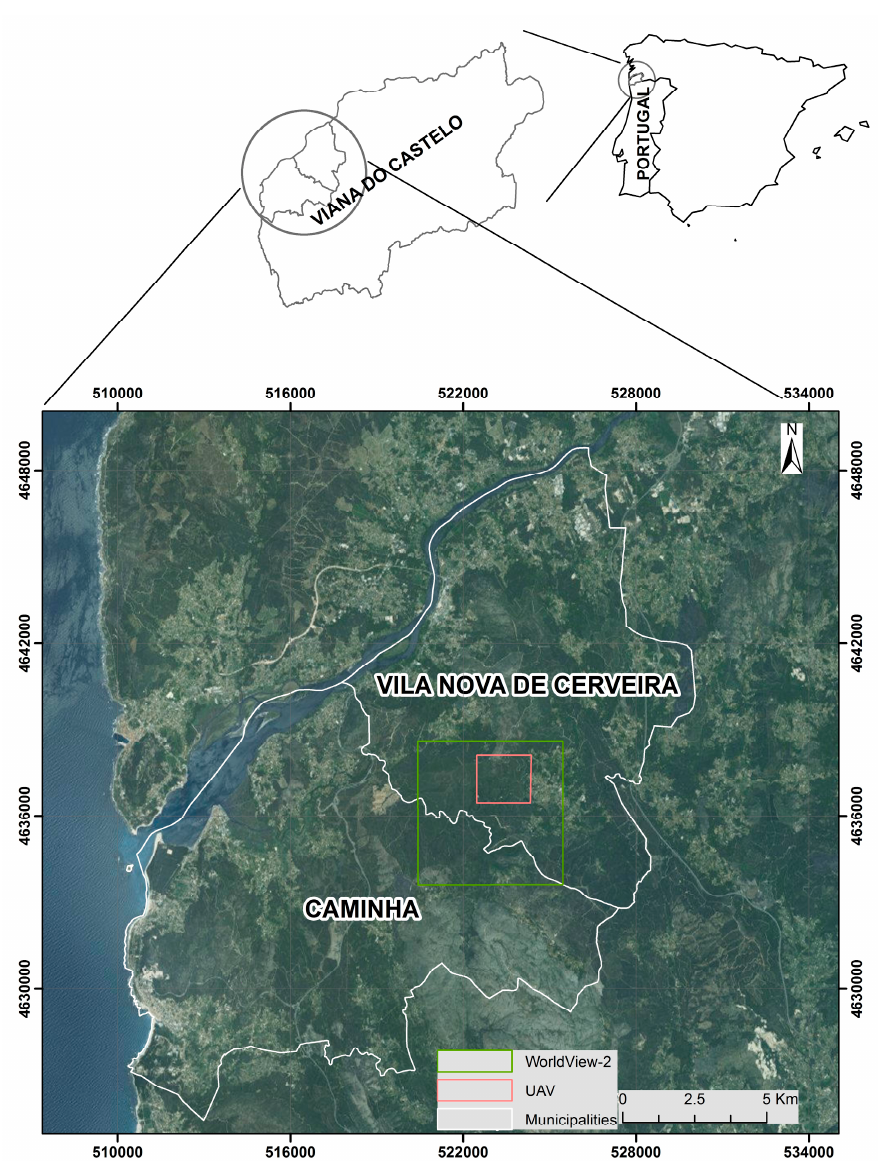
Figure 1. Study area located in Viana de Castelo (the North of Portugal), in the municipalities of Caminha and Vila Nova de Cerveira. Most of the land is covered by forests, shrubs or uncultivated fields. Coordinate reference system: WGS84 UTM29.